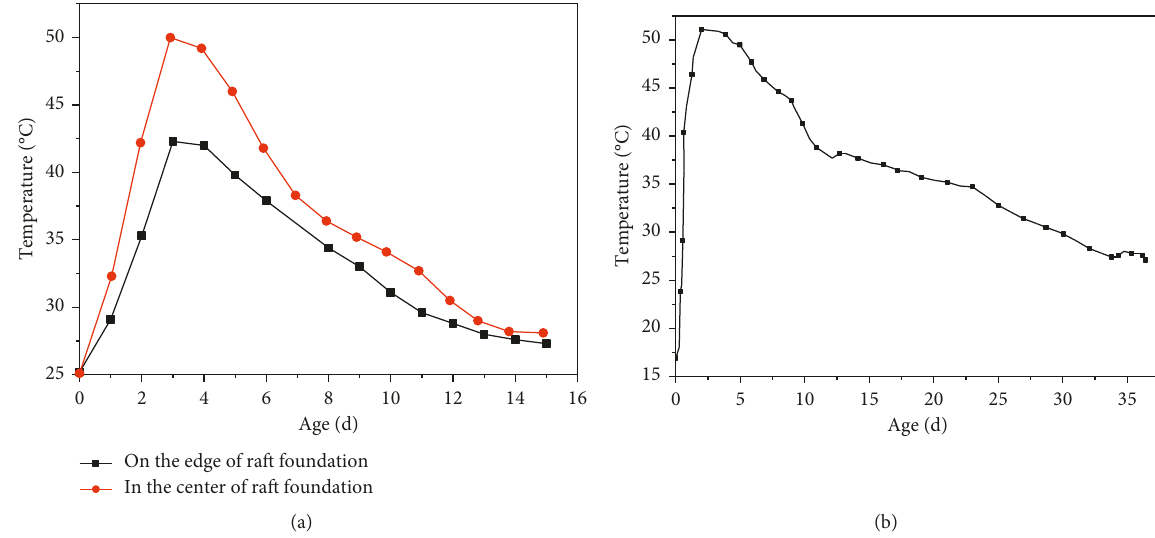
Figure 4: Curves showing the variation of temperature with increasing age of the concrete. (a) The measured values of the temperature field of the concrete at different points of a raft foundation and (b) the measured temperature field value of the concrete at the center of the base of an arch dam [46,